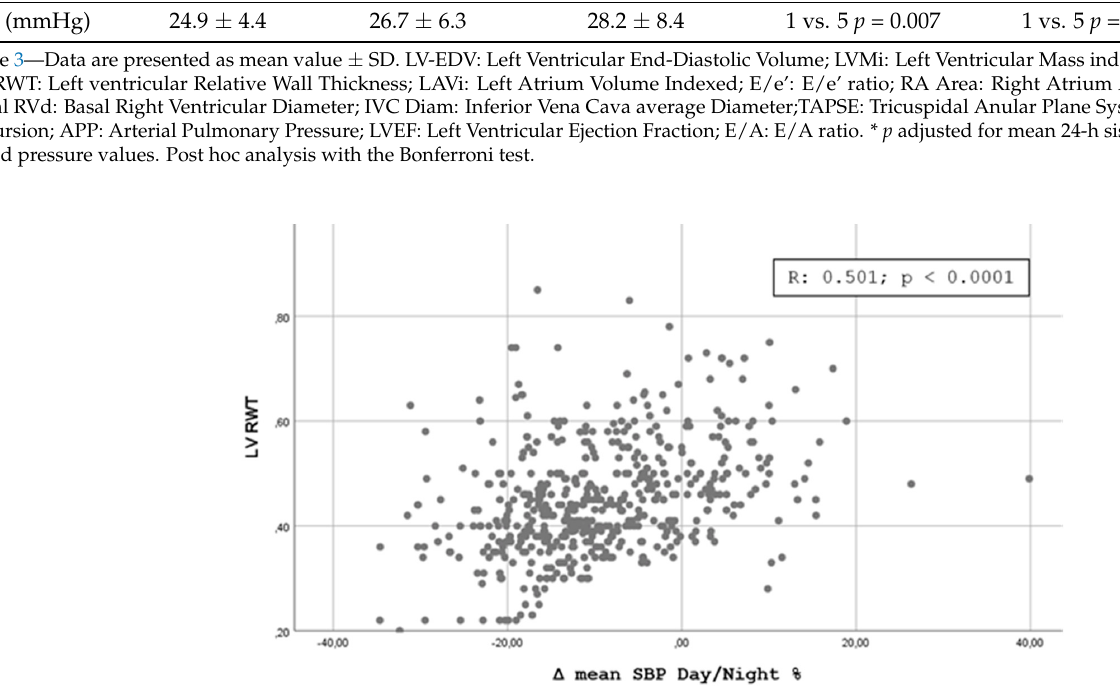
Figure 1. Scatterplot showing the Pearson’s correlation analysis for nocturnal reduction of blood pressure and Left Ventricle RWT.